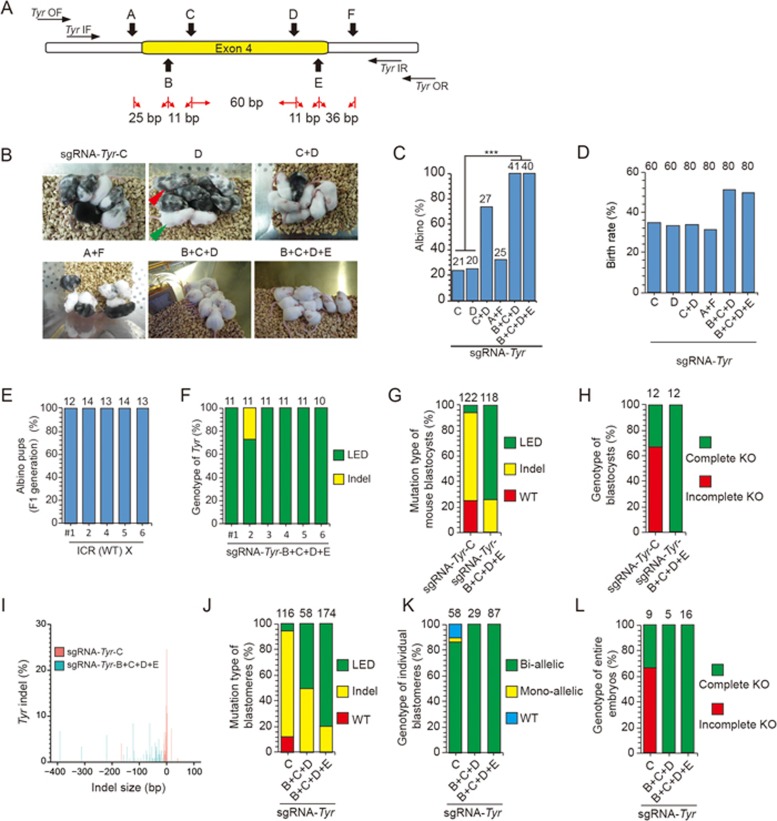
One-step generation of Tyr complete knockout mice by C-CRISPR. (A) Schematic diagram of sgRNA-targeting sites at Tyr locus. The space between each sgRNA is from the end of last base of one sgRNA to the first base of another sgRNA (including PAM sequence). (B) Representative results of pigmentation phenotypes of mice resulting from Tyr targeting. Green arrowhead, albino; red arrowhead, mosaic pigmentation. (C) Histograms showing the percentage of albino mice resulting from Tyr targeting. Two or more targeting sgRNAs (sgRNA-Tyr-C+D, B+C+D, or B+C+D+E) resulted in higher percentage of albino mice than single-sgRNA targeting (sgRNA-Tyr-C or D). Number, total number of mice counted (***P < 0.001, χ2 test). (D) Birth rate of mice resulting from Tyr targeting. Number, total number of embryos transferred. (E) Reproductive ability and germline transmission of Tyr knockout mice by C-CRISPR. Five gene-modified mice (sgRNA-Tyr-B+C+D+E) were mated with WT ICR mice individually. Each pair of mice gave birth to two litters of pups. (F) Albino mice resulting from sgRNA-Tyr-B+C+D+E targeting were sequenced. DNA was isolated from tails of albino mice and PCR amplified. #2 mice contained large-fragment exon deletion and indels. LED, large-fragment exon deletion; Indels, insertion, or deletion of bases. Number above each column, total TA clones sequenced. (G and H) Percentages of different mutation types (G) and genotypes (H) of blastocysts resulting from Tyr targeting. Number, total TA clones sequenced and analyzed. WT, wild-type allele. Complete KO, blastocyst with complete knockout mutations; Incomplete KO, blastocyst with WT allele and knockout mutations. Number, total blastocysts counted. (I) Size distribution of deletions or insertions in blastocysts with Tyr targeting. (J and K) Percentages of different mutation types (J) and genotypes (K) for individual blastomeres of 8- to 16-cell embryos with Tyr targeting. LED, large-fragment exon deletion; Bi-allelic, bi-allelic mutations; Mono-allelic, mono-allelic mutations. Number, total alleles, or blastomeres analyzed. (L) Percentages of different genotypes of entire 8- to 16-cell embryos with Tyr targeting. Number, total embryos analyzed.